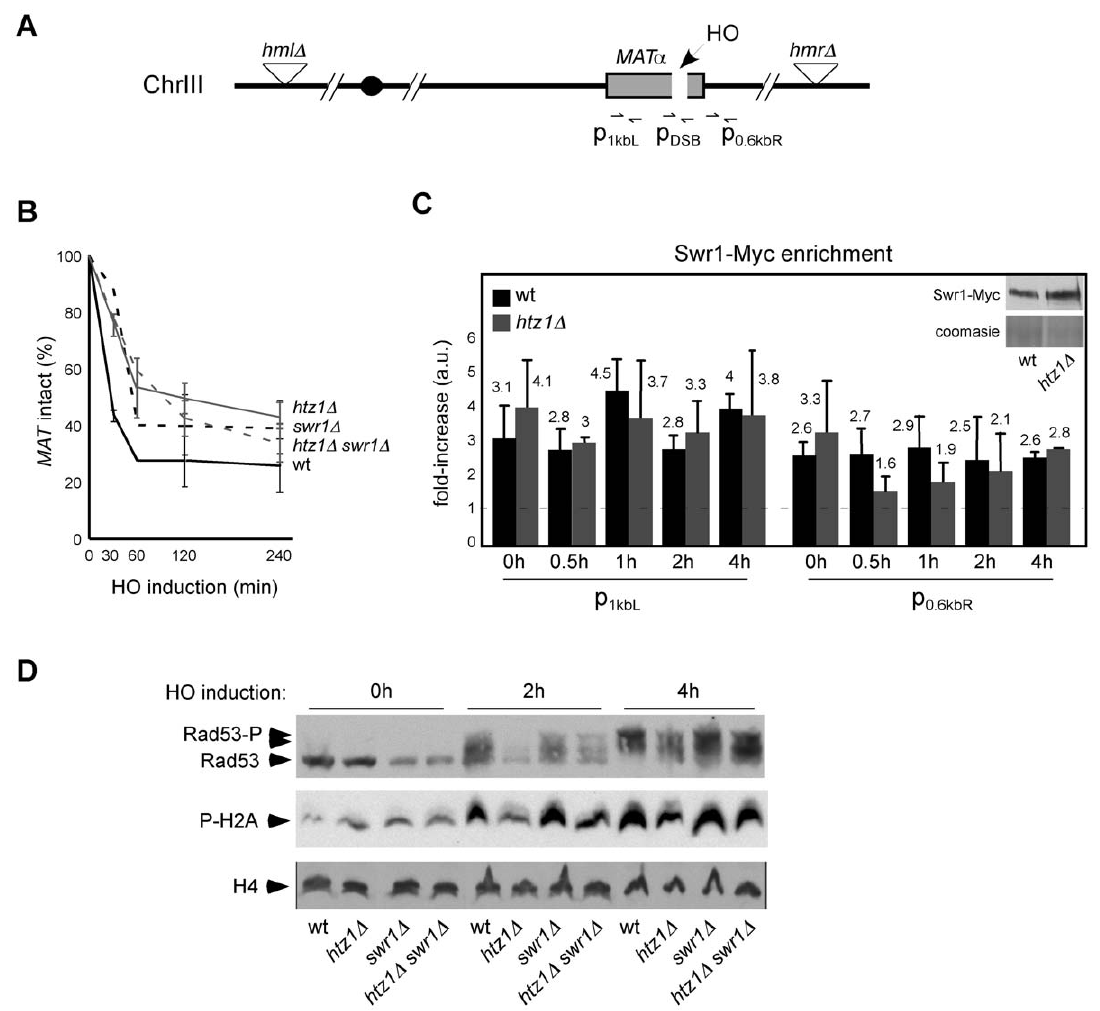
Figure 3. The SWR1 complex impairs DSB processing in the absence of Htz1. ( A ) Schematic representation of the MAT locus and deleted HML and HMR donor sequences at chromosome III. The position of the DNA fragments amplified by qPCR for cleavage efficiency and ChIP analysis is indicated. ( B ) Accumulation of HO-induced DSBs at MAT over time. ( C ) Swr1-Myc enrichment at both sides of the cleavage site at MAT by ChIP analysis. Both input and ChIP DNA were amplified by real-time PCR with amplicons situated at the regions shown in (A) (see Table S4 for oligos). The enrichment at each zone is graphed relative to the enrichment in the wild-type strain incubated with IgG, taken as 1. Similar results were obtained using as a control the untagged strain incubated with the anti-Myc antibody. ( D ) DSB-induced phosphorylation of Rad53 (Rad53-P) and histone H2A (P-H2A) over HO digestion by western blot. All the experiments were performed in JKM179.